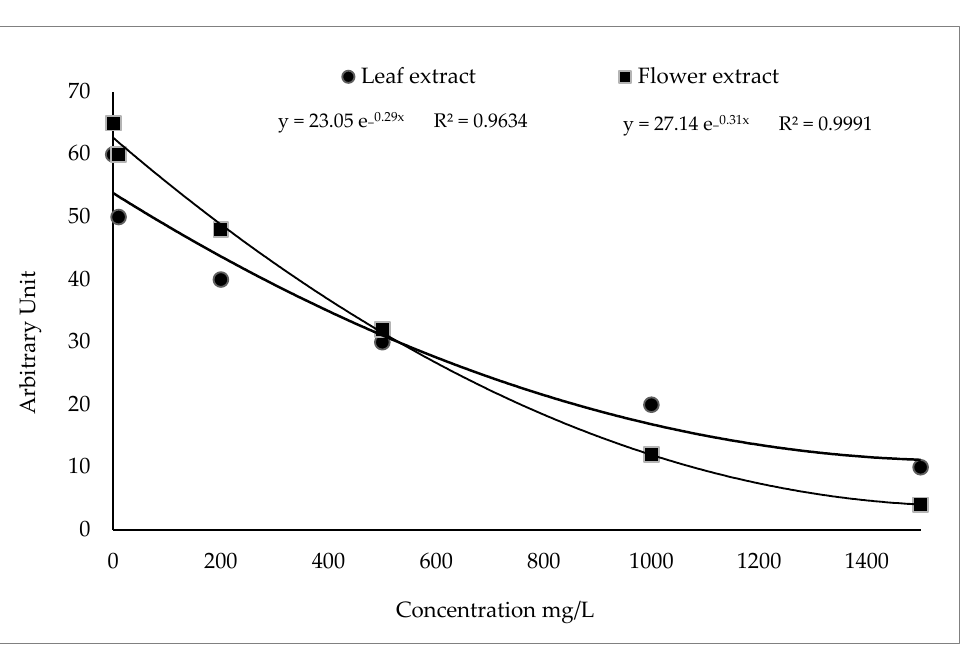
Figure 1. Decrease in the spectrum intensity of the spin adduct of CH 3 O − with the increase in A. vulneraria leaf and flower concentrations.